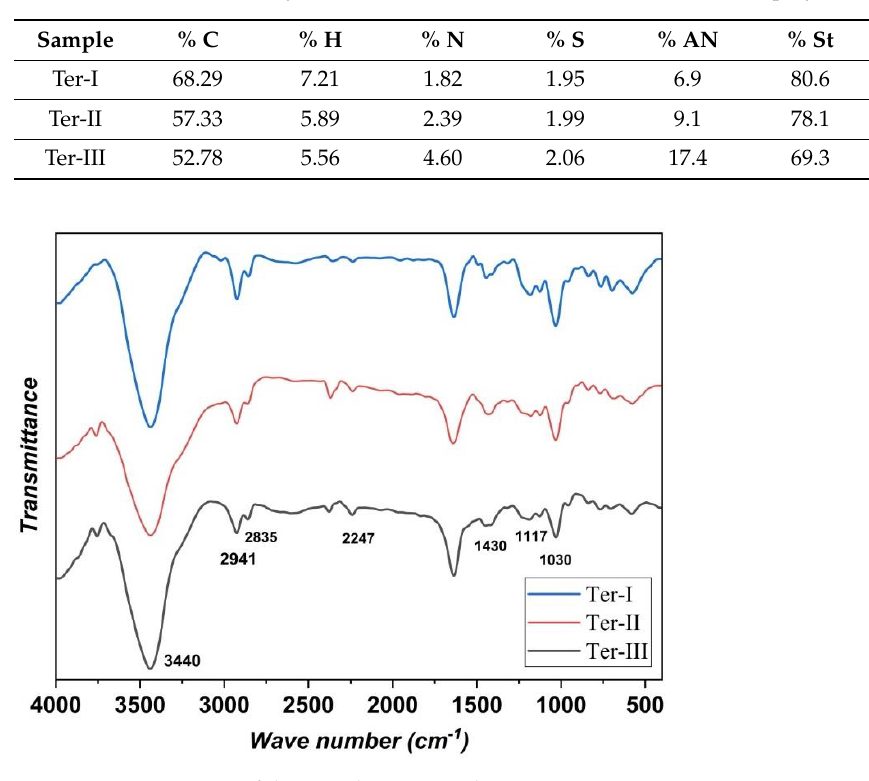
Figure 1. FTIR spectra of the terpolymer samples. Table 2. The elemental analyses and the calculated monomer ratios of the terpolymer species.